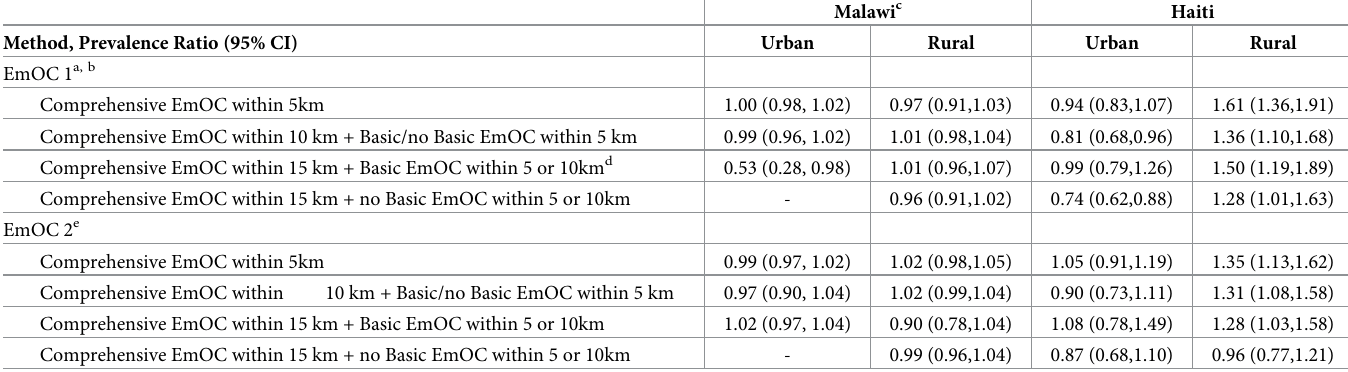
Table 4. Urban-rural differences in the association between proximity to obstetric care on place of delivery among women in Malawi and Haiti using two EmOC assessment methods: 2014–2018 DHS and SPA